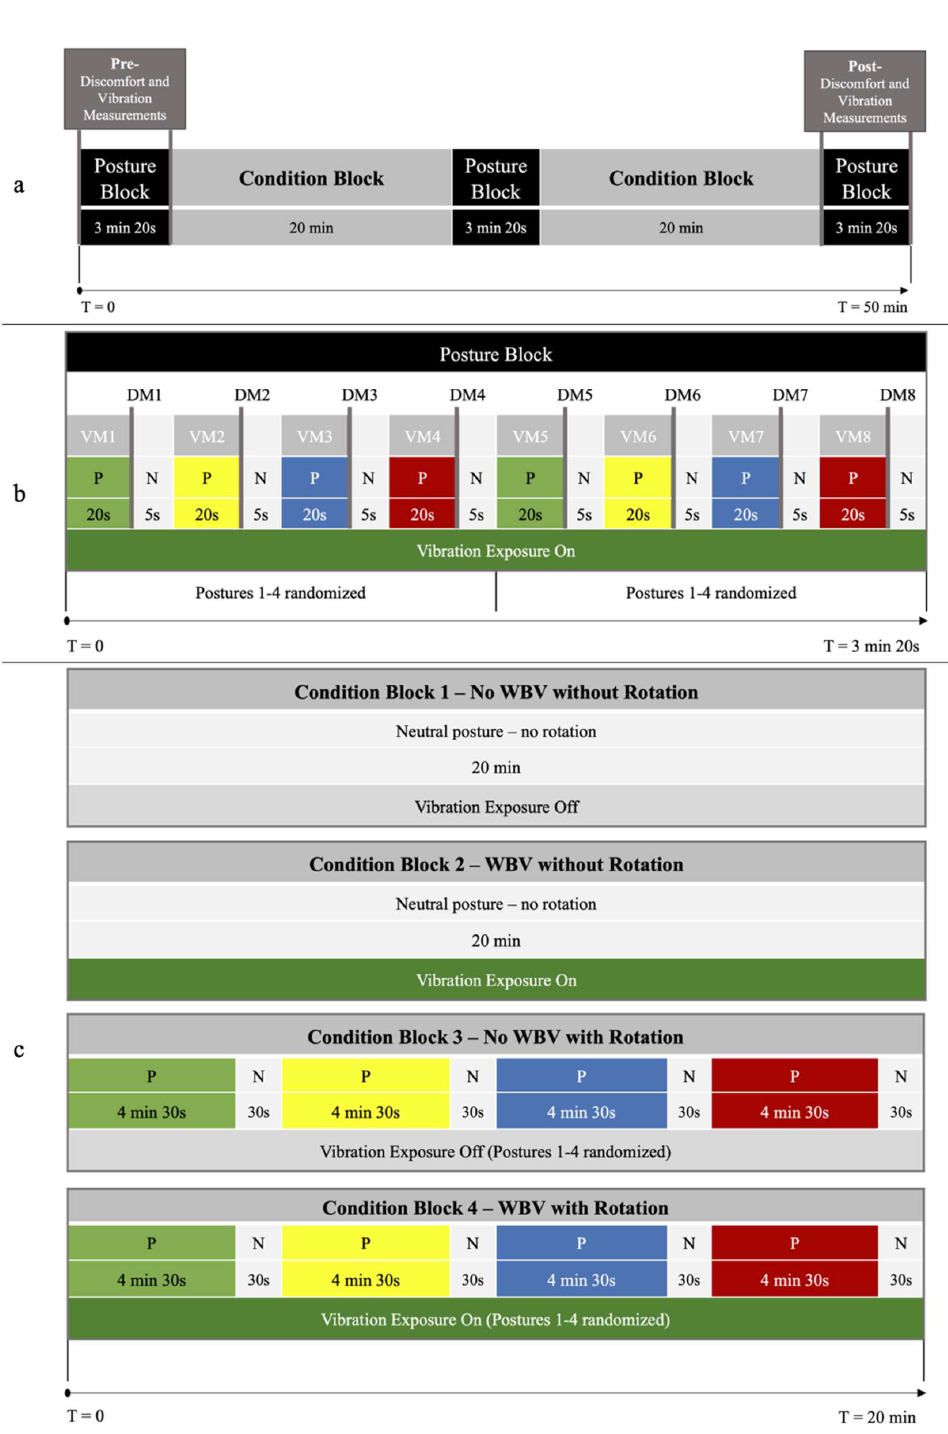
Figure 3. A schematic timeline overview of ( a ) an overall test session, ( b ) the posture block (where discomfort and vibration measurements occurred), and ( c ) the four possible condition blocks. Dark grey vertical lines on the test session ( a ) indicate when pre- and post-discomfort and vibration measures were taken. Light grey blocks indicate when vibration was off and green blocks indicate when vibration was on. DM: discomfort measurement; VM: vibration measurement; N: neutral posture; P: posture (1 of 4); T: time; min: minutes; s: seconds.